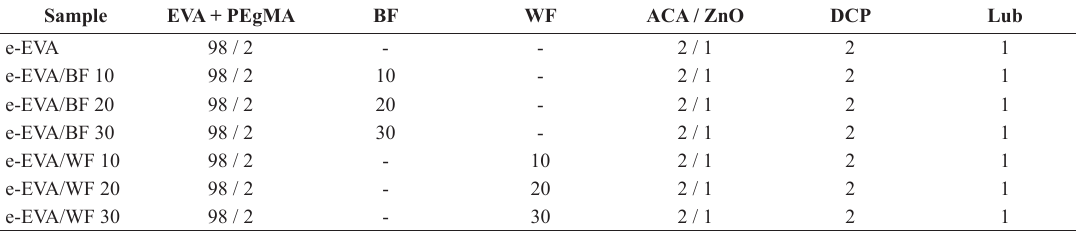
Table 1. Compositions of the samples with and without reinforcement agents, in parts per hundred parts of resin (phr).